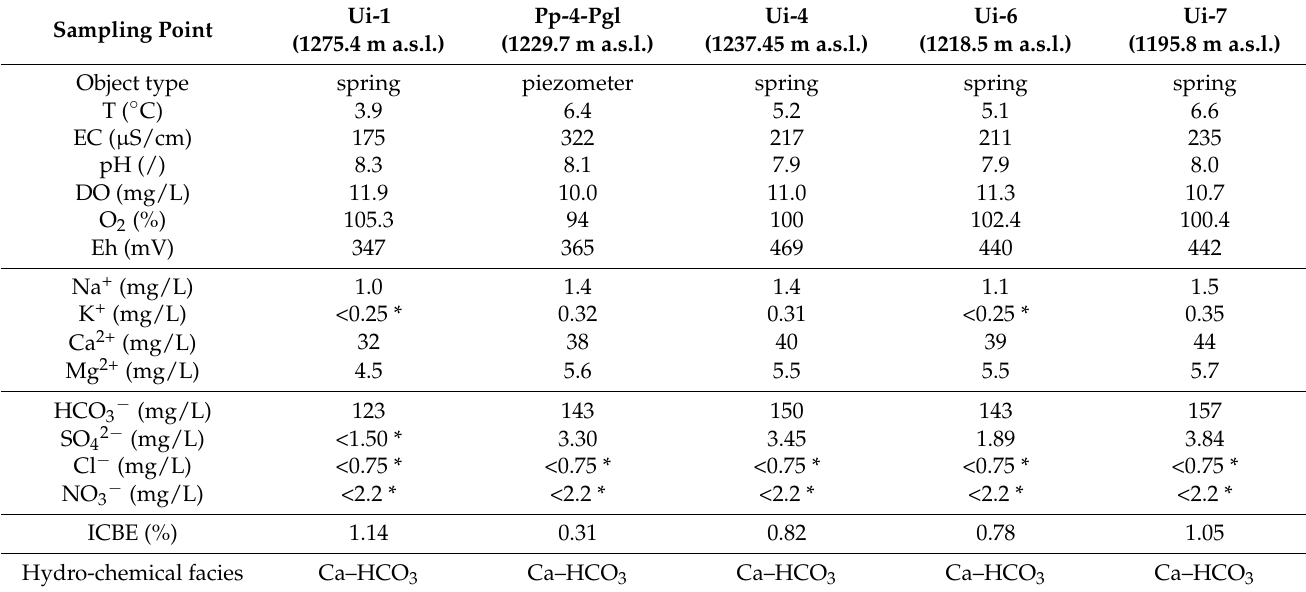
Table 1. Physico-chemical field parameters and major ions in groundwater measured on 21 June